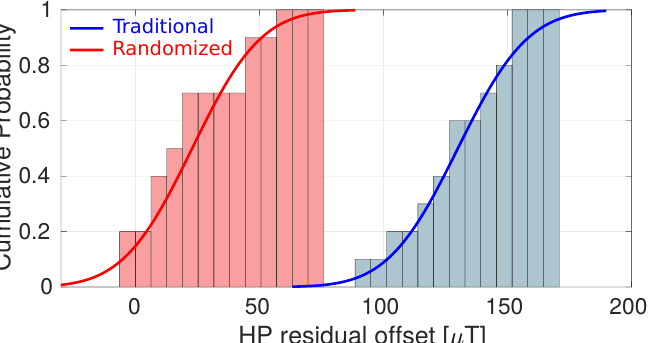
Figure 17. Cumulative distribution over 10 samples of the input-referred Hall plate residual offset with traditional four-phase spinning (blue) and randomized four-phase spinning (red). The full lines correspond to a cumulative Gaussian fitted to the associated cumulative